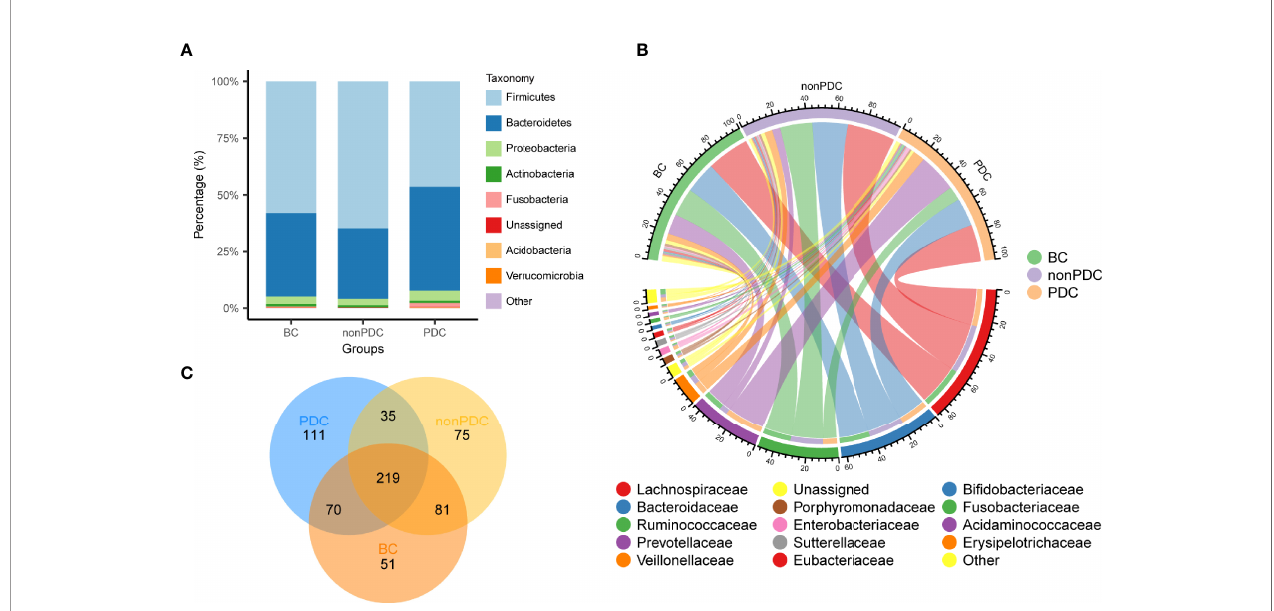
FIGURE 2 | Overview of the gut microbiome in different groups. (A) Dominant phyla in each group. (B) Dominant families and their contribution to each group. (C) A Venn diagram demonstrating the existence of ASVs in each